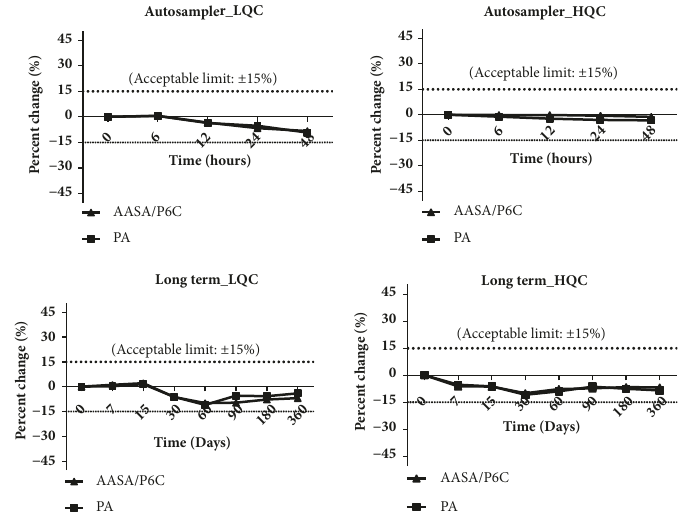
Figure 3: Autosampler and long-term stability studies of low quality controls (LQC) and high-quality controls (HQC) of 𝛼 -amino adipic semialdehyde, piperidine-6-carboxylic acid, and pipecolic acid.